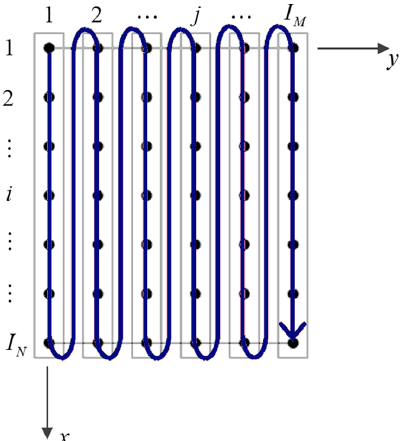
Figure 3. Grid point order for the implementation of the Generalized Differential Quadrature (GDQ) technique within a two-dimensional domain [2].